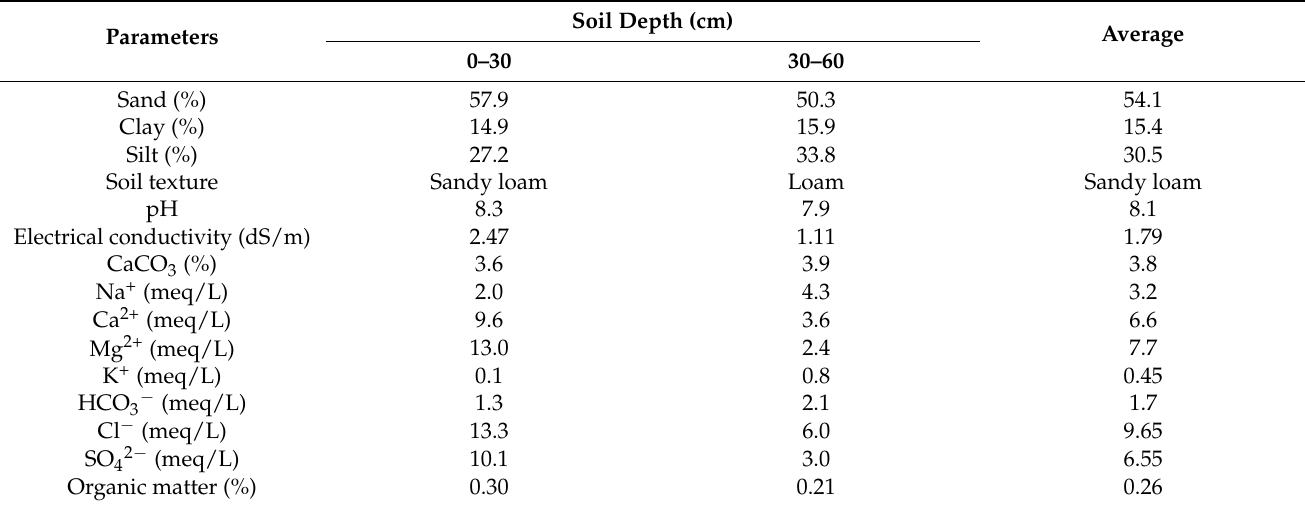
Table 1. Observed soil parameters at the test